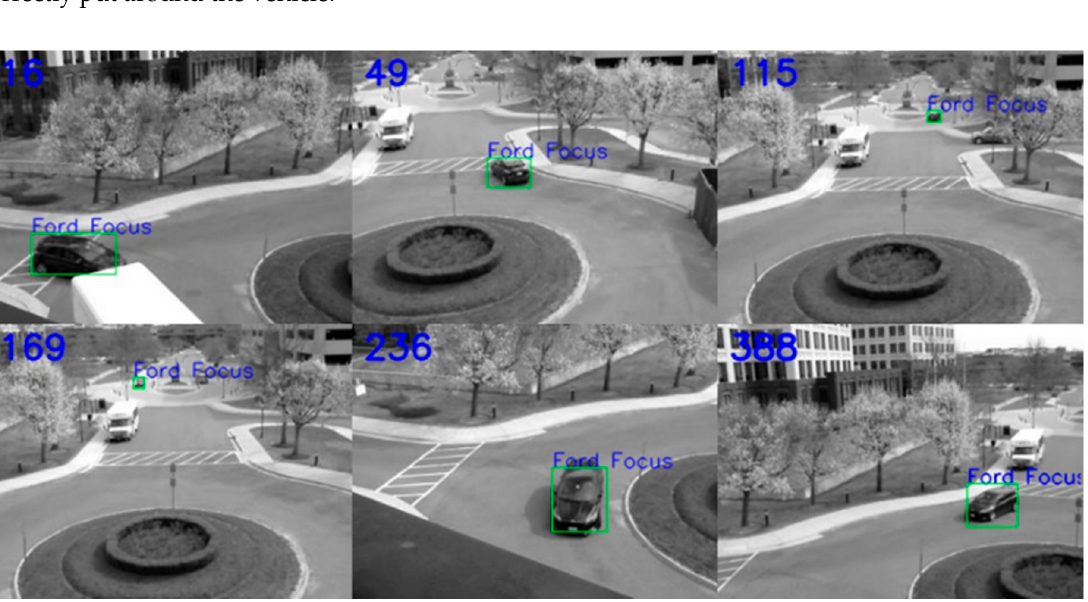
Figure 8. JHU Balcony 0 percent missing pixels, tiled image results. Bounding box detections outlined in green. The vehicle is Ford Focus.